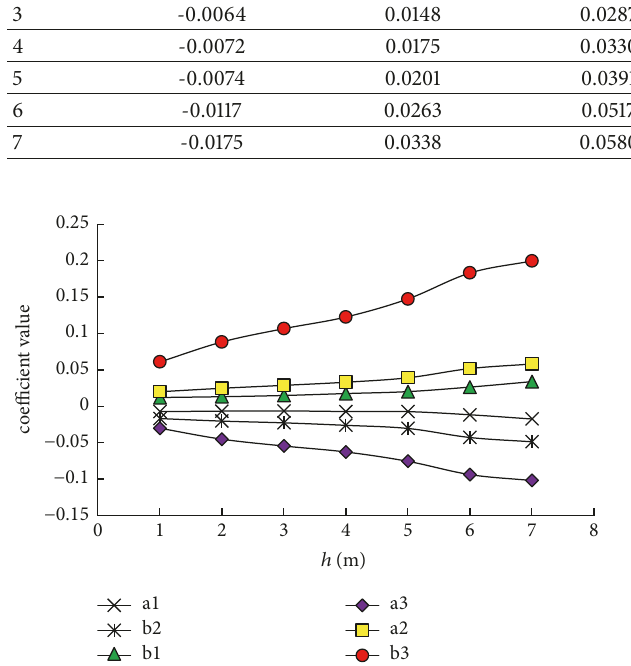
Figure 15: Relationship between filling height and 𝑎 𝑖 , 𝑏 𝑖 .